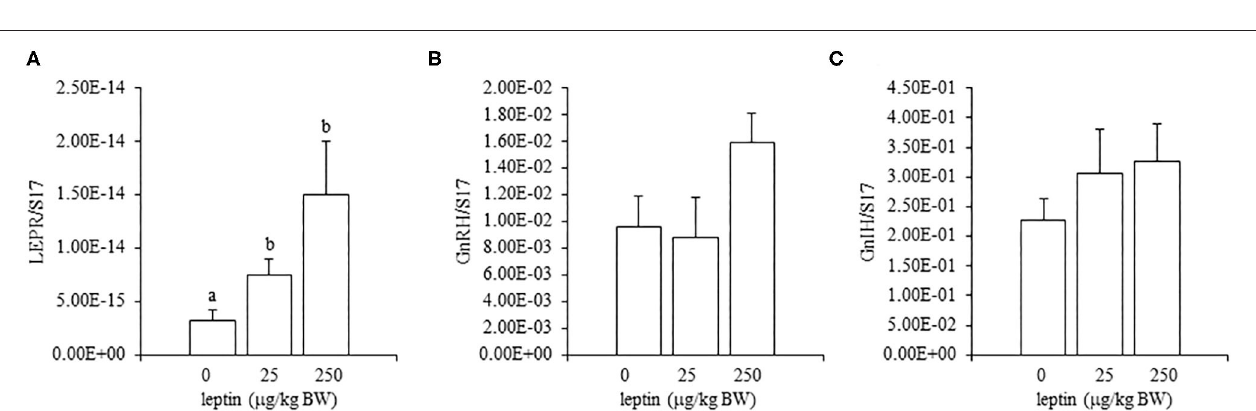
FIGURE 6 | Hypothalamic mRNA expression of LEPR (A) , GnRH1 (B) , and GnIH (C) at 24h after leptin administration in the 28-day-old chicks. Chicks were injected i.p. with 0, 25, and 250 µ g/kg BW of rmleptin. The data represent the mean ± SEM ( n = 6), and bars with different superscripts are significantly different.